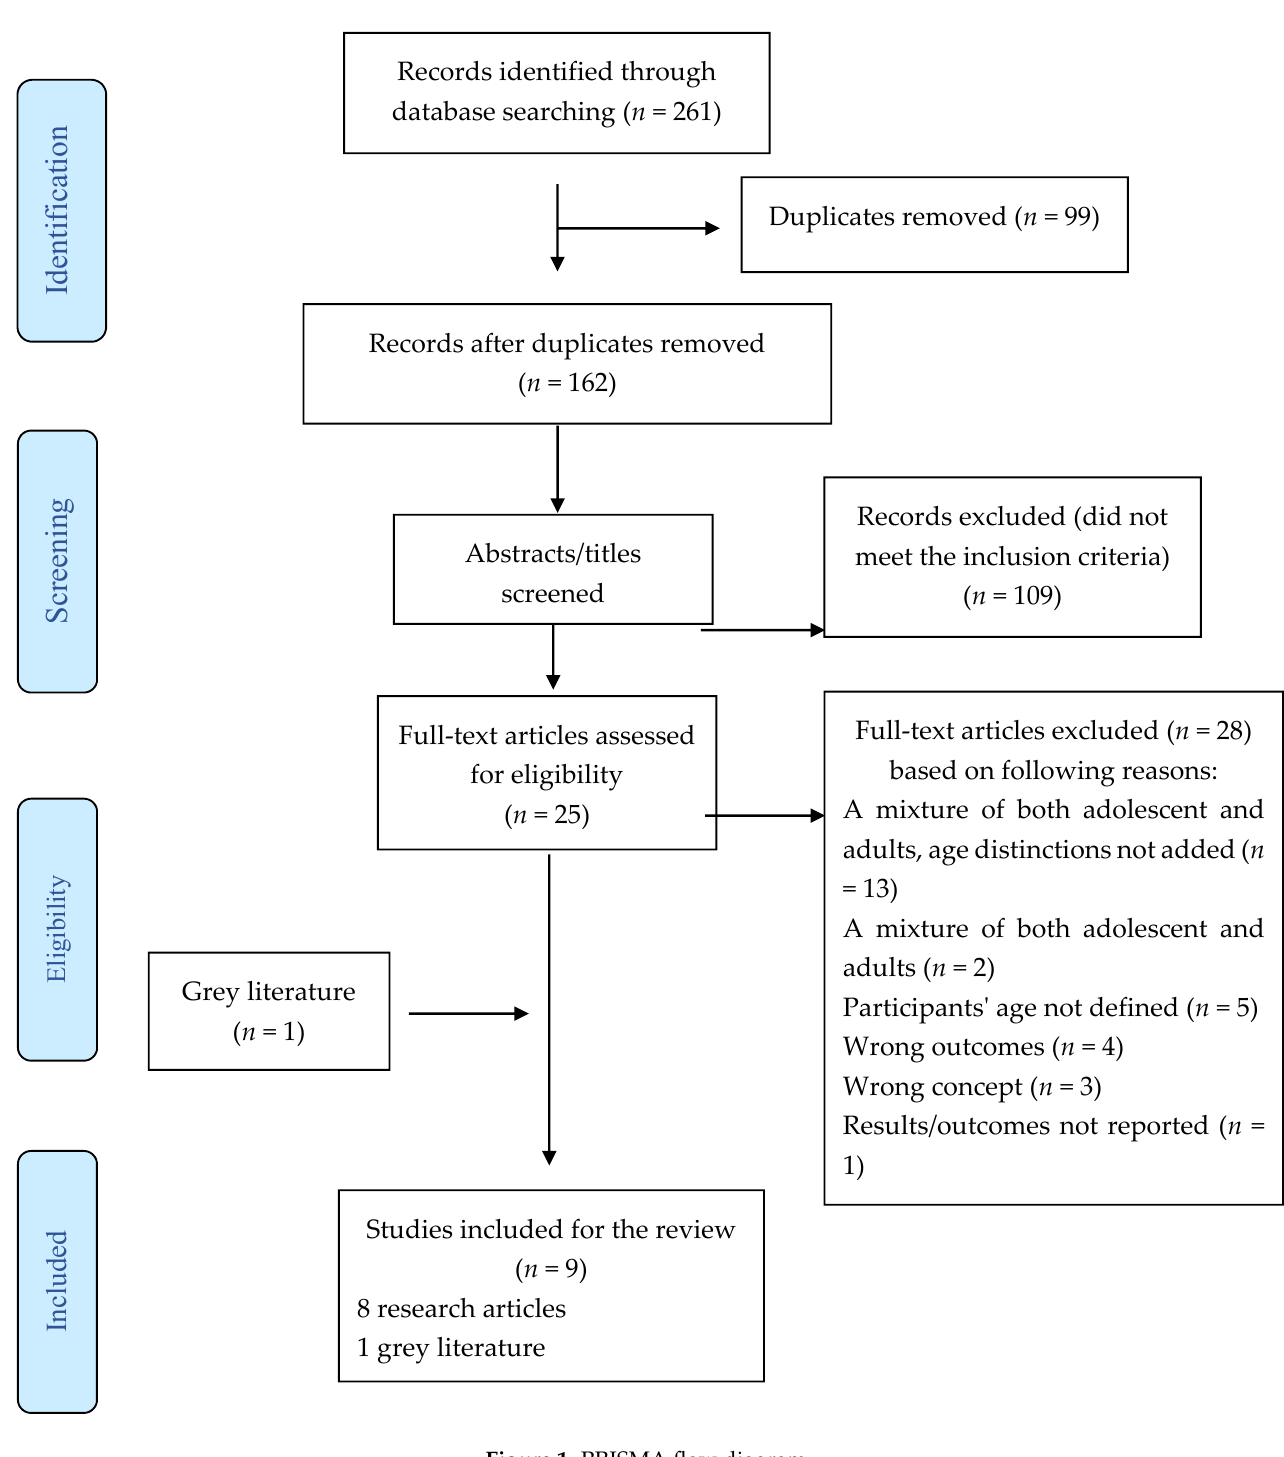
Figure 1. PRISMA flow diagram.